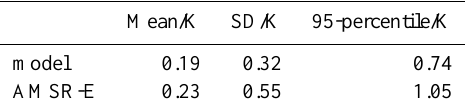
Table 1. Global statistics of the day-night temperature differences at AMSR-E locations and times, June 2006–May 2007.